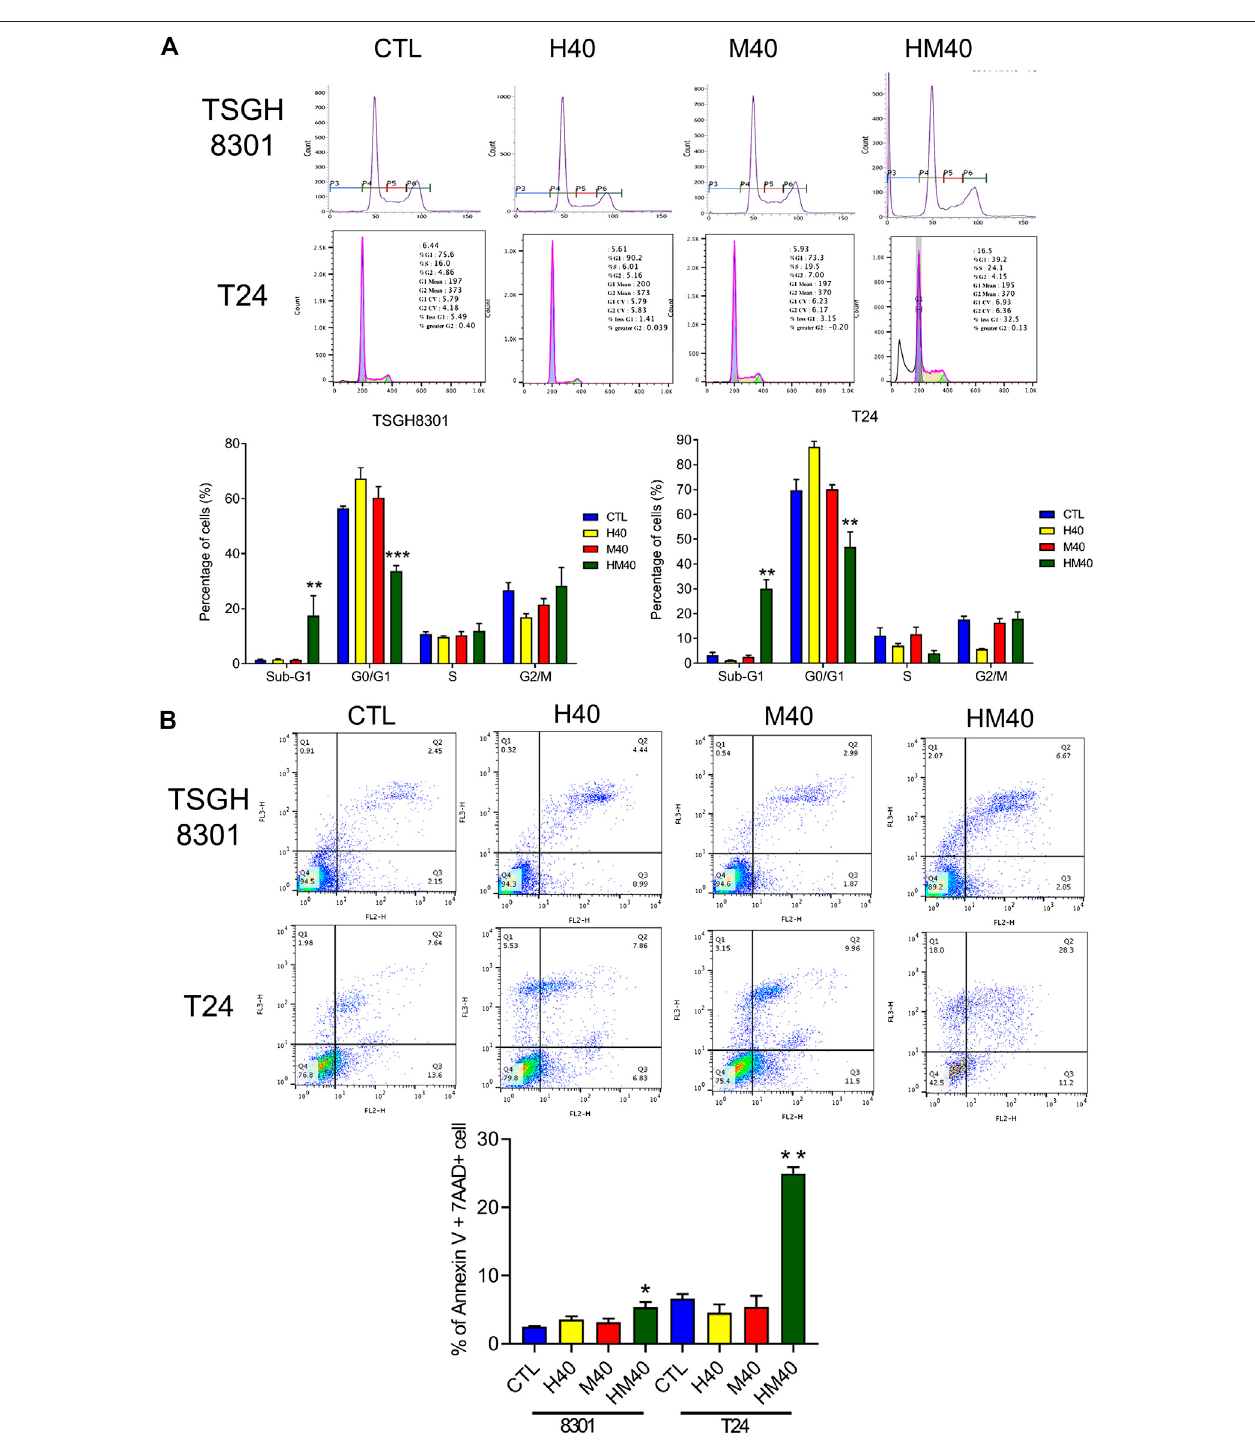
FIGURE2| CellcycleregulationandapoptosisinductionbyHono,Mag,andHono-Magcombinationtreatmentinhumanbladdercancercells. (A) TSGH8301and T24 bladder cancer cells were treated with Hono, Mag, or Hono/Mag (40 μ M) for 24 h. Cell cycle expression was then analyzed by FACS. Quantitative analyses of the populations of cells in difference phases of the cell cycle were conducted using BD FACSuite analysis software, and the results are shown in the lower panel. (B) TSGH8301 and T24 bladder cancer cells were treated with Hono, Mag, or Hono/Mag (40 μ M) for 24 h. The proportions of apoptotic cells were determined using Annexin V/7AAD staining and fl ow cytometry analysis. The lower panel shows the percentage of apoptotic cells. * p < 0.05; ** p < 0.01; *** p < 0.001 compared to the control group.